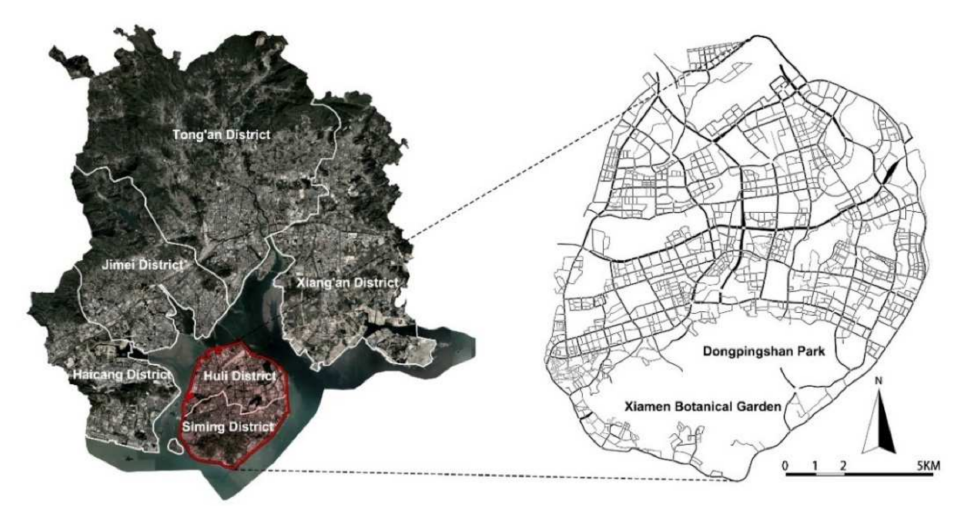
Figure 1. Location and street system on Xiamen